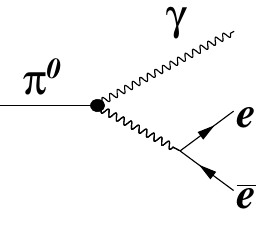
Figure 3. A dark photon can appear in all meson decays with a lepton